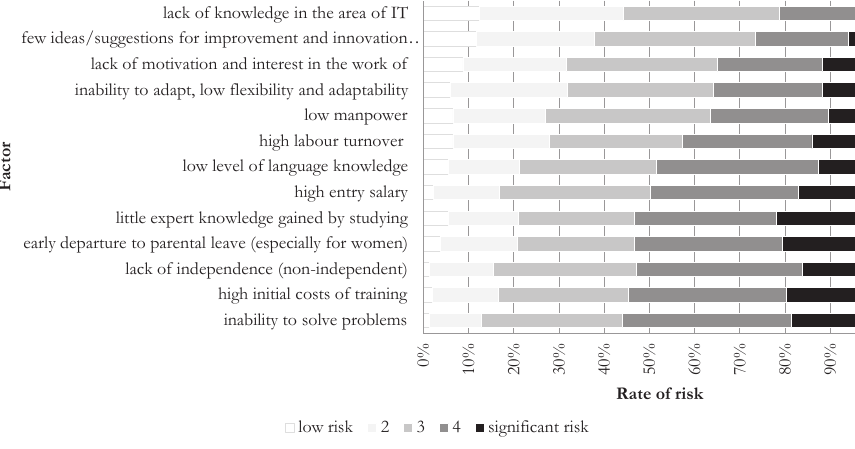
Fig. 2 – Risk factors of graduate success in the labour market. Source: